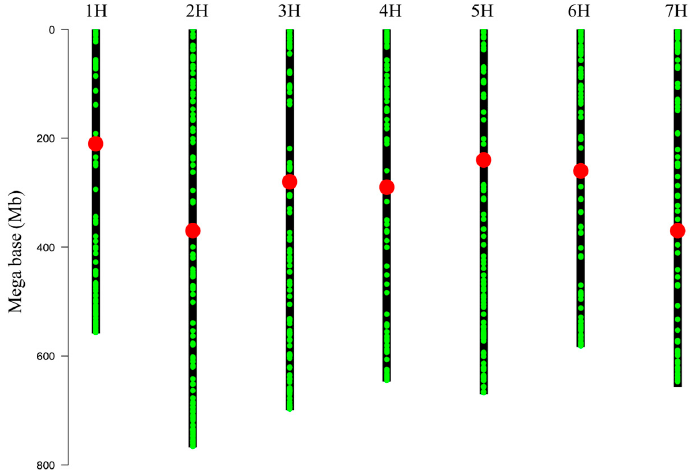
Figure 4. Karyogram showing the chromosomal positions of novel miRNAs on chromosomes 1 to 7H of barley ( Hordeum vulgare ). The position of each miRNA is shown using a green circle. Centromeres are represented using a red oval. The final karyogram was drawn using the ggplot function in the ggplot package of R and an R script, as described [34]. Table 2. Most abundant miRNA families in three barley genotypes under BYDV infection and healthy controls. No. of Novel miRNAs